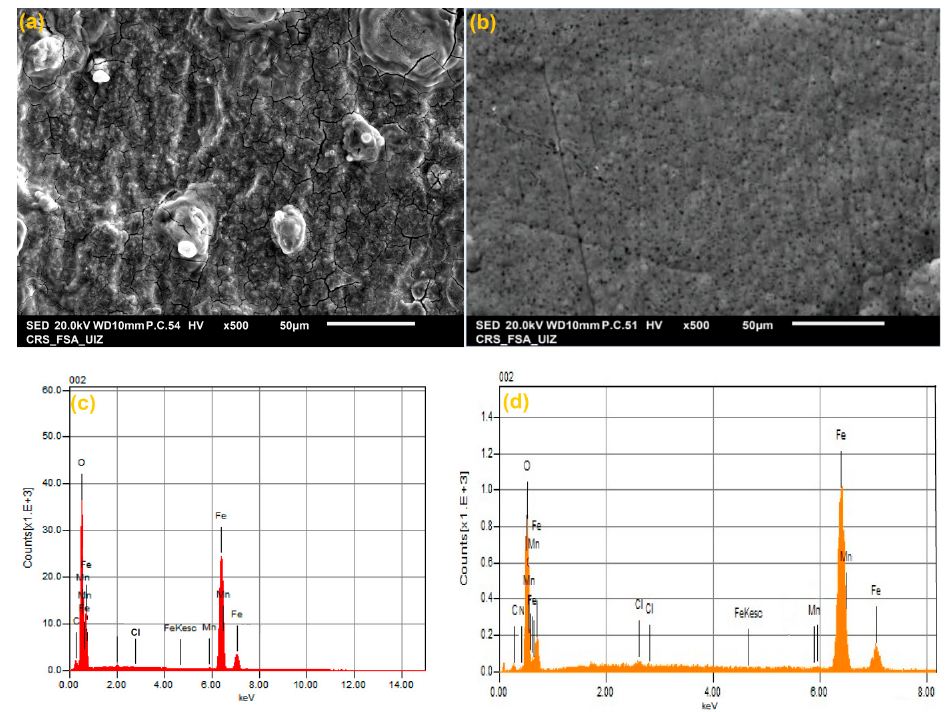
Figure 10. SEM and EDX photographs of mild steel specimens after 24 h of immersion in 1.0 M HCl solution in the absence ( a , c ) and the presence of 5 × 10 − 3 M of HYD-1 ( b , d ).